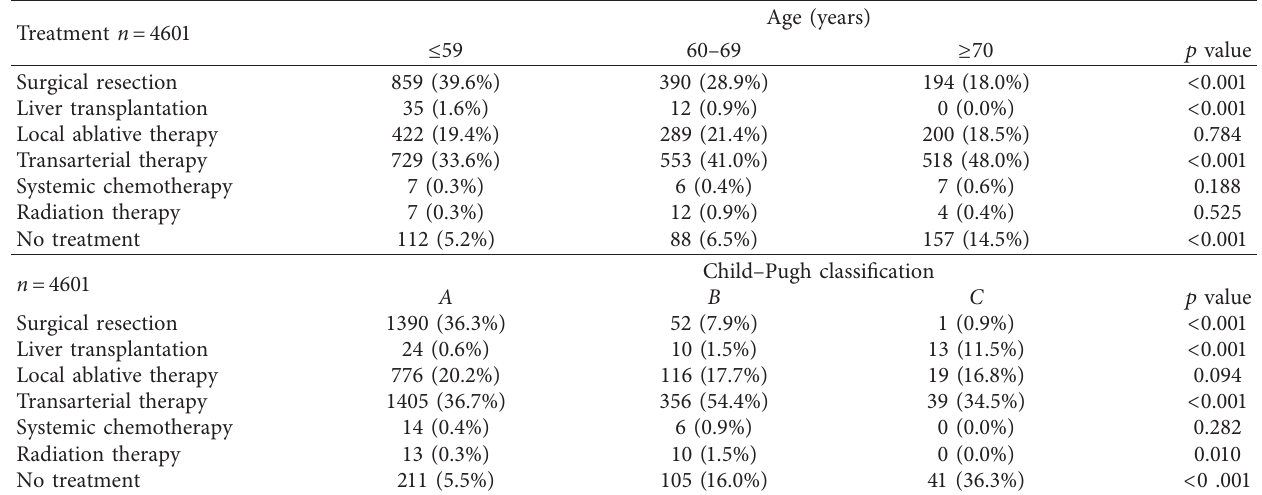
Table 2: Treatment pattern change by age and the Child–Pugh classification in single lesions.